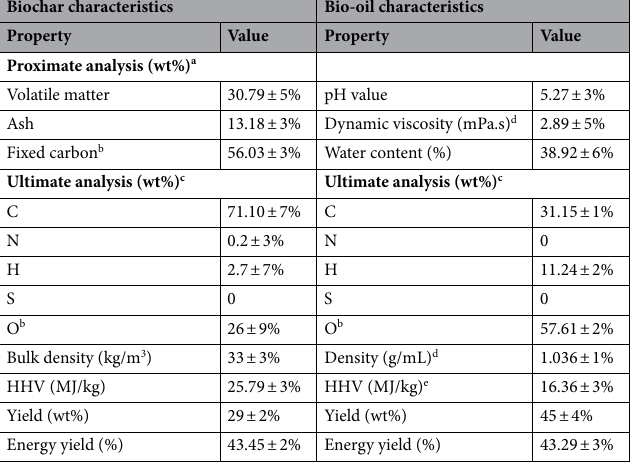
Table 4. Main properties of biochar and bio-oil from microwave pyrolysis of corn stover with AC. [ a Dry basis, b Calculated by difference, c Dry and ash-free basis, d Density and viscosity at 25 °C, e Calculated by HHV